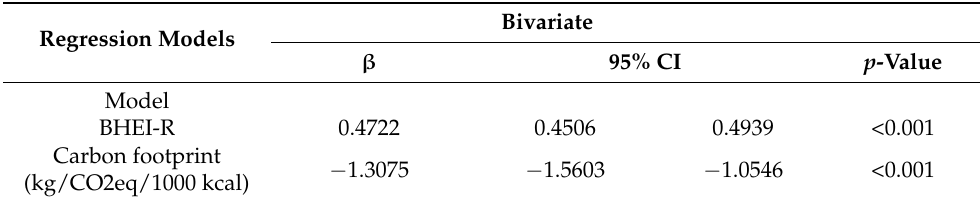
Table 5. Association between Planetary Health Diet Index and overall dietary quality and carbon footprint. ELSA-Brasil, 2008–2009. Regression